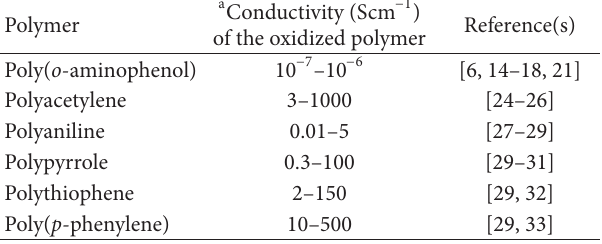
T 2: Conductivity of some typical electroactive